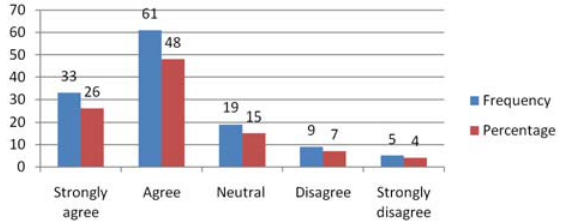
Fig. 1. Level of domestic taxation impact on business